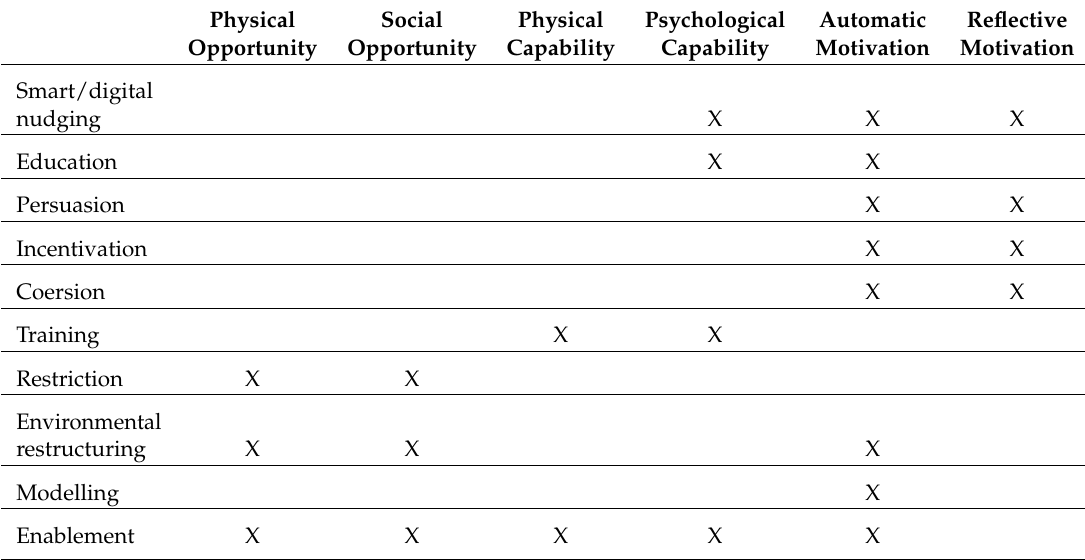
Table 4. Comparison of intervention functions for behavioral change, with links to capability, opportunity and motivation (links for all interventions except smart/digital nudging is from